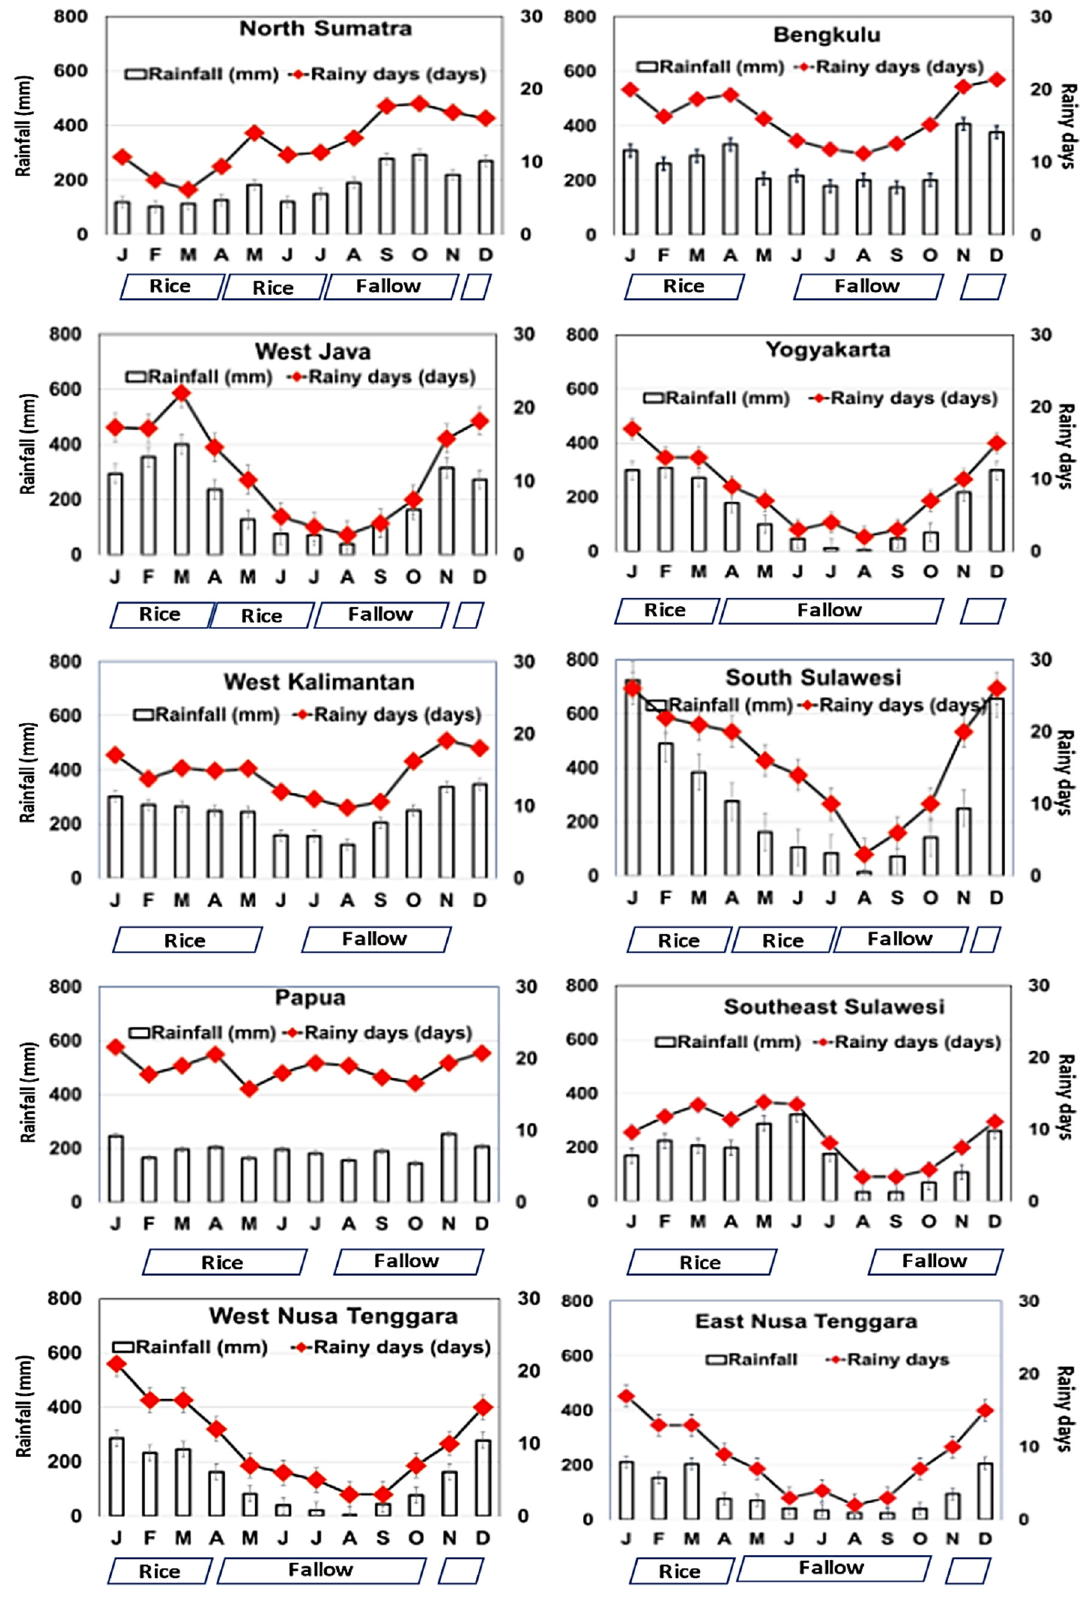
Figure 2. Rainfall (left axis, in mm − 1 ), rainy days (right axis, number of rainy days month − 1 ) and the scheme showing existing cropping sequences in rainfed lowland areas in Indonesia’s ten provinces used as study sites, as shown in Table 1. Boxes show approximate crop cycle length, from sowing to harvest maturity.